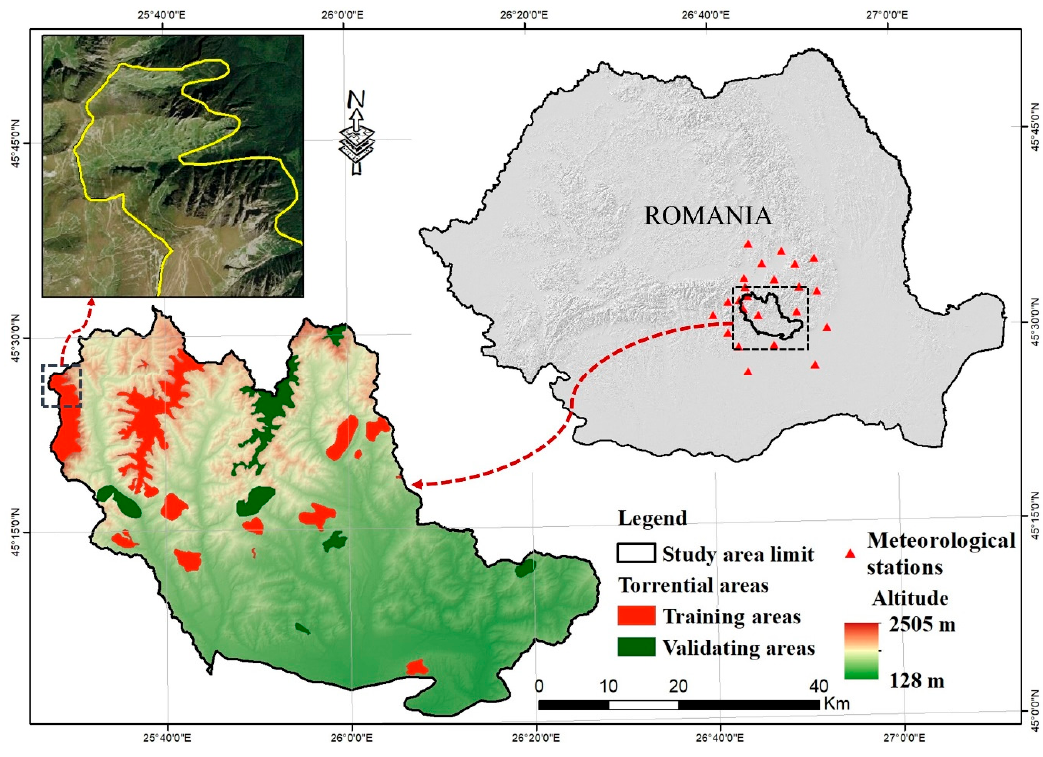
Figure 1. Location of the study area.